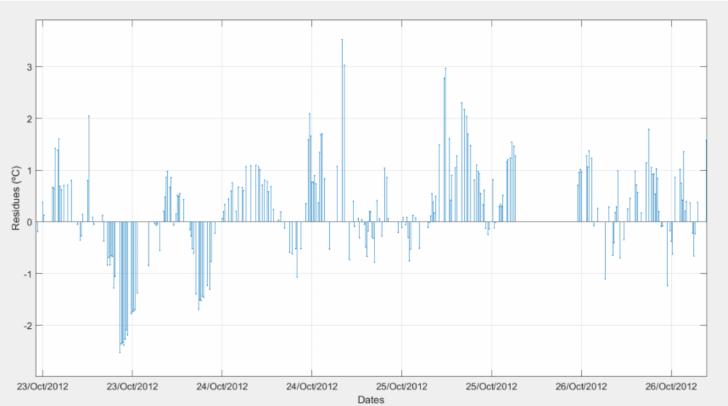
Figure 11. Sample of a group of remainders used to calculate the